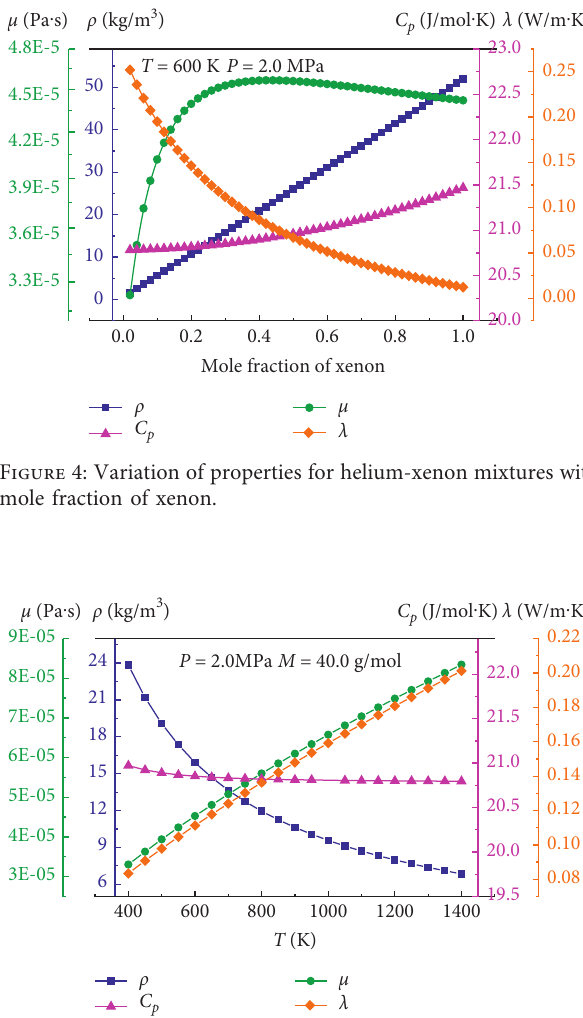
Figure 5: Variation of properties for helium-xenon mixture with temperature.